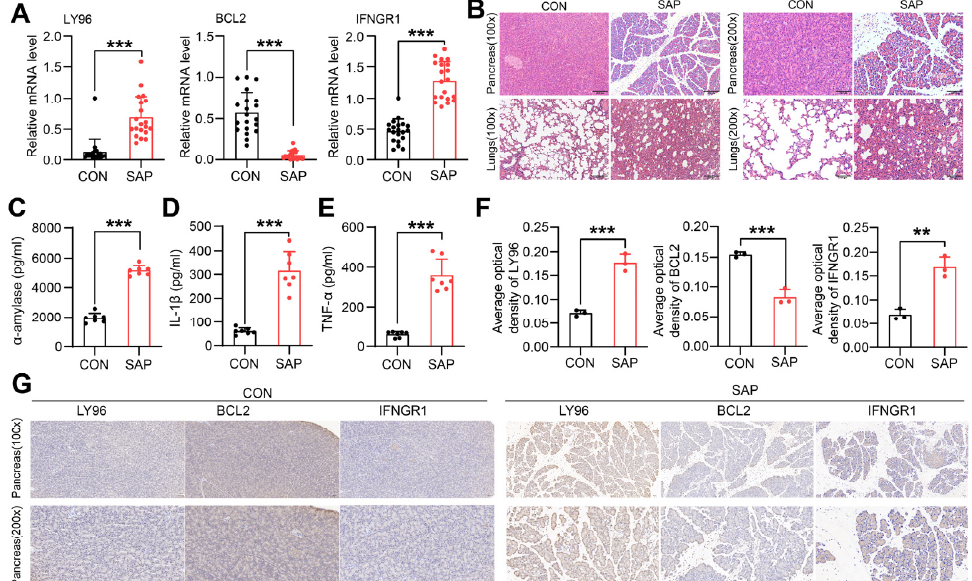
Figure 9. Clinical and animal experimental validation of ICD-related hub genes. ( A ) Relative mRNA expression of the three hub genes in SAP patients versus healthy controls; ( B ) Representative HE- stained micrographs of the pancreas and lungs (original magnification × 100 and × 200); ( C – E ) Serum expressional levels of α -amylase, IL-1 β , TNF- α by ELISA. ( F ) Immunohistochemical plots showing hub genes in SAP rats and controls (original magnification × 100 and × 200); ( F ) Semiquantitative results of hub genes based on immunohistochemistry. ( G ) Immunohistochemical plots showing hub genes in SAP rats and controls (original magnification × 100 and × 200). Data are shown as mean ± SEM, ** p < 0.01, *** p <